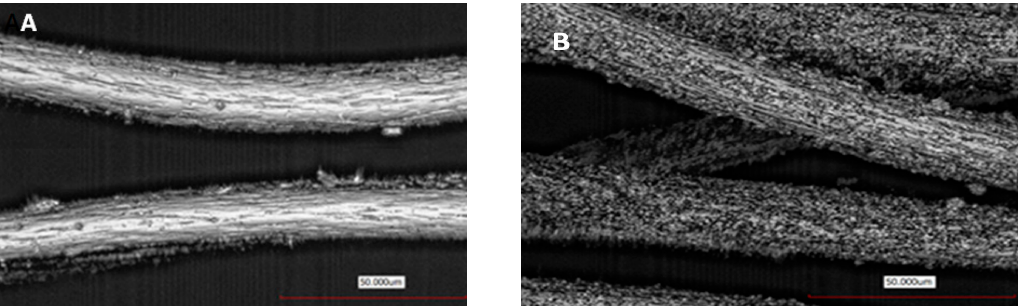
Figure 5. Wool fibers before ( A ) and after ( B ) halloysite dispersion exposure.